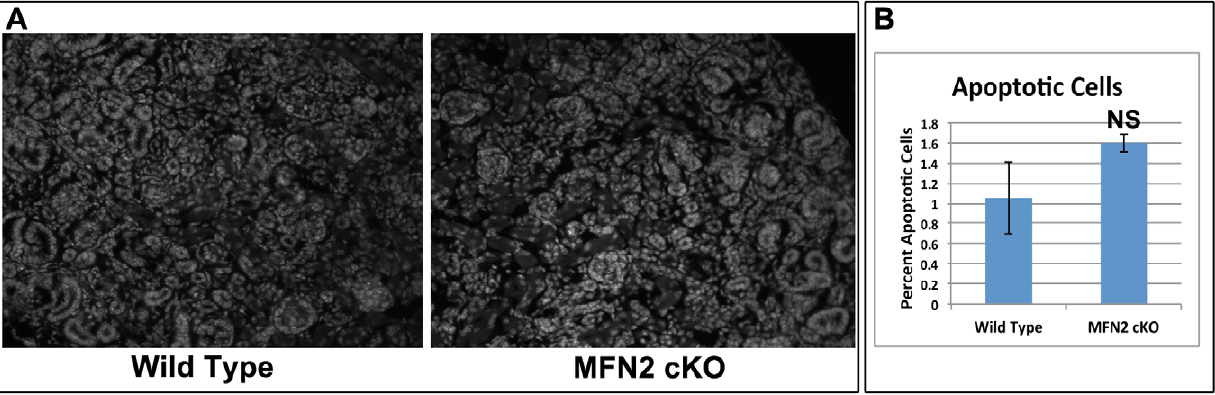
Figure 3. Effect of MFN2 conditional knockout on renal apoptosis. ( A ) Wide field fluorescent microscopy of kidney sections from wild type and MFN2 cKO four day old littermates stained with Hoechst dye injected intraperitoneally prior to sacrifice; remarkably few apoptotic cells were detected in either group. ( B ) Quantitative analysis of apoptotic cells in kidney sections of wild type and MFN2 cKO mice (n=5/group). Data represent the mean and SD; * P . 0.05.